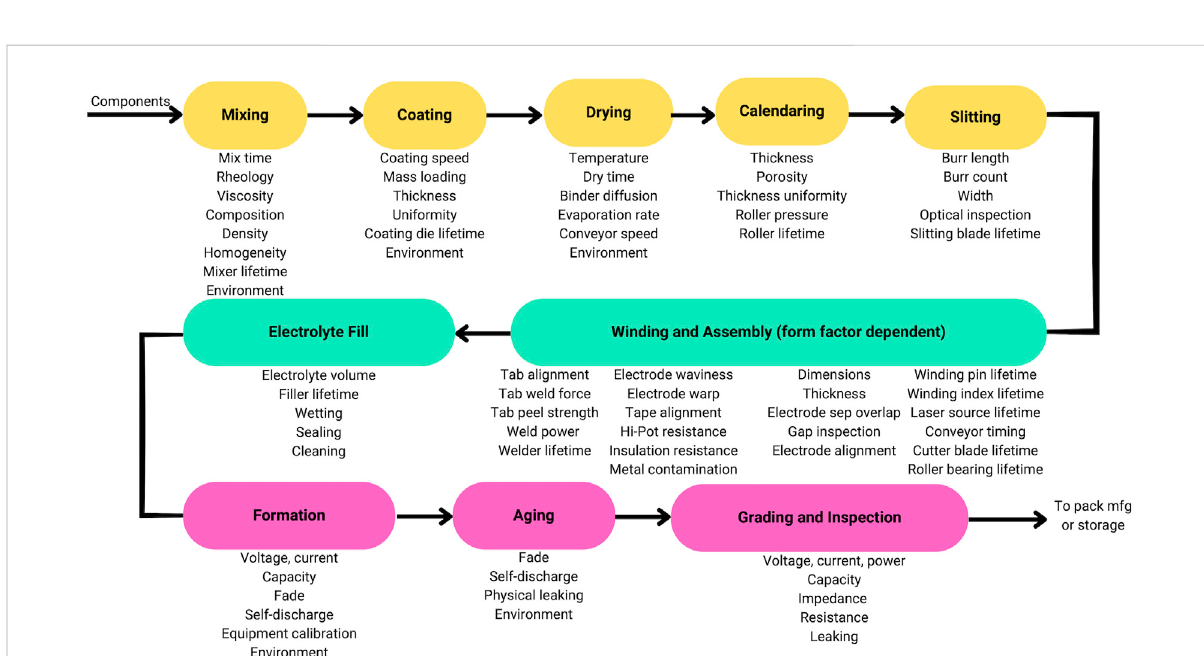
FIGURE 6 Metadata associated with the three phases of processes involved in cell